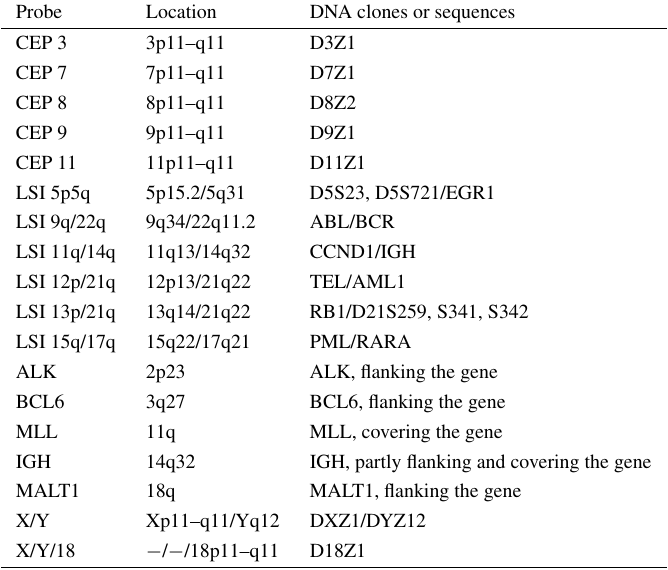
Locations on HSA chromosomes and DNA clones or sequence of the different probes and probe combinations like CEP 3/7, 7/8, 7/9, 8/9, 9/11, X/Y, LSI 9q/22q, 11q/14q, and 13p/21q; tri-colour probe X/Y/18; and bi-colour fusion probes ALK at HSA 2p23, BCL6 at HSA 3q27, 5p5q (EGR), MLL HSA 11q, IGH at HSA 14q32 and MALT1 at HSA 18q used in this study (also consult